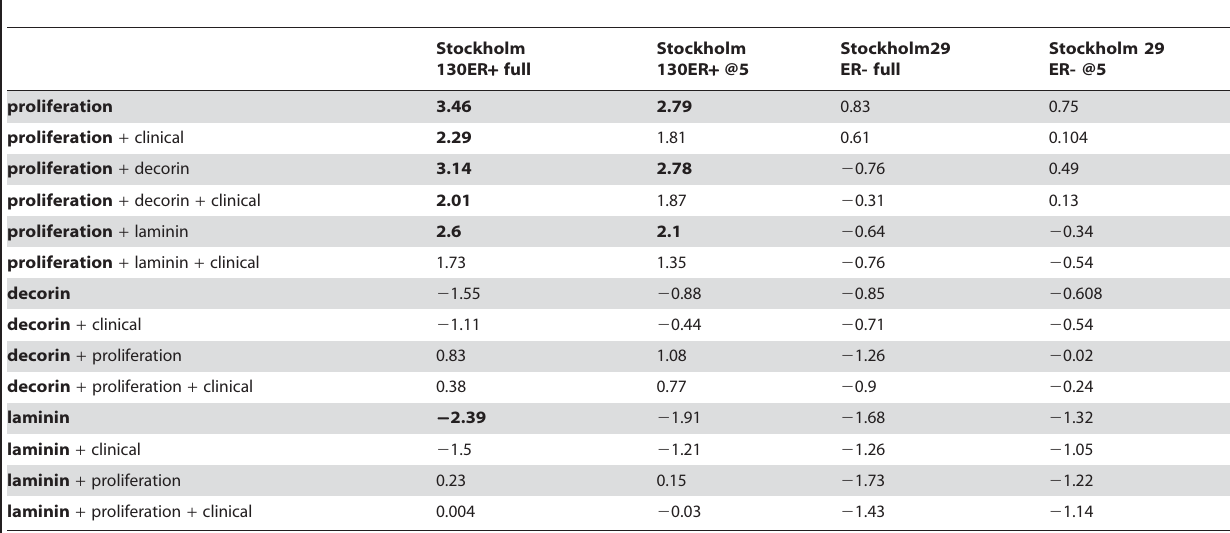
Table 5. Cox proportional hazards models for the STOCKHOLM